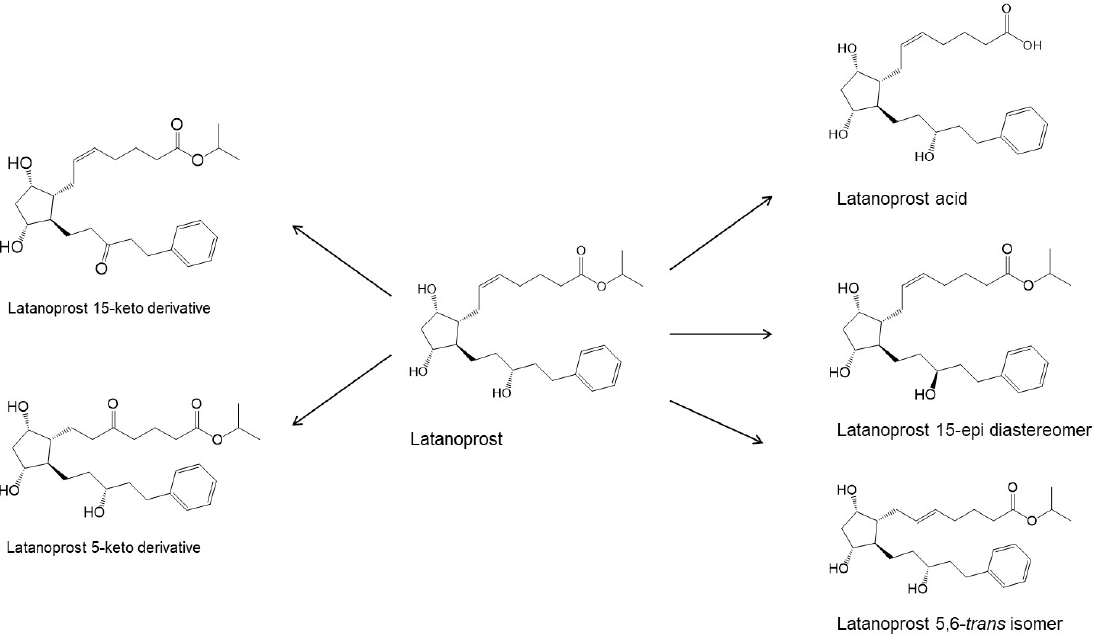
Figure 1. The main degradation products of latanoprost. Based on USP43-NF38 and Ph. Eur. 10.3, as well as reference [22]. Other degradation products have also been identified during forced degradation under somewhat extreme conditions [22].